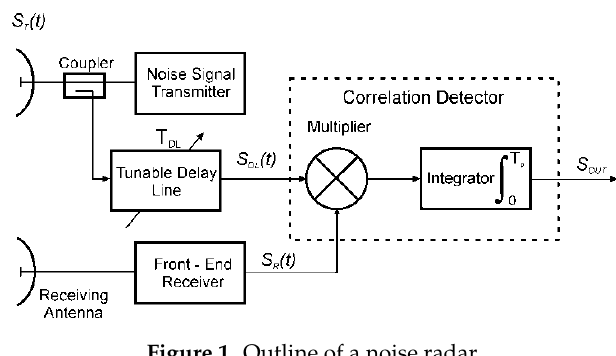
Figure 1. Outline of a noise radar.